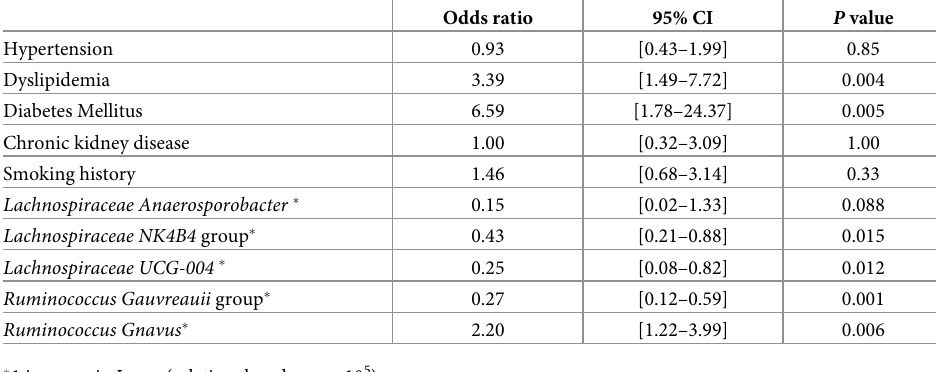
Table 3. Univariate logistic regression analysis to predict the development of